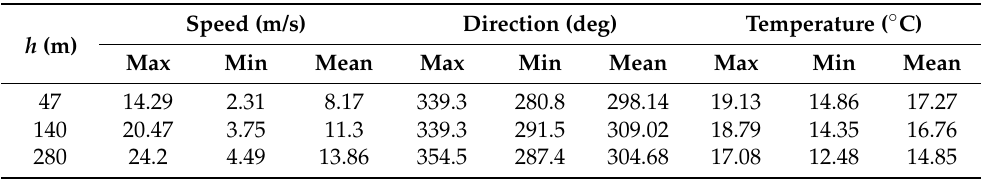
Figure 12. The 10-min mean wind speed ( a ), wind direction ( b ), temperature ( c ) and friction velocity normalized by the mean wind speed u ∗ / U , ( d ) history of the synoptic event which occured on 5 May 2017, related to the heights of 47 m, 140 m and 280 m. Table 4. Comparison of the wind data of three heights related to the duration between two vertical lines in Figure